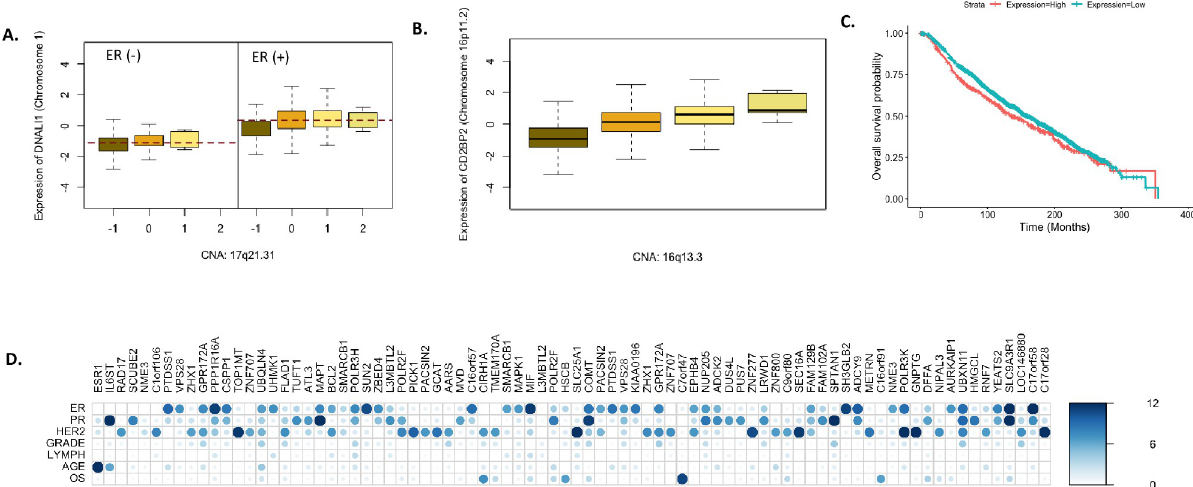
Fig 3. Association analysis with breast cancer related outcomes. (A) DNALI1 gene on chromosome 1 associated with ER status and trans-regulated by a CNA of transcription factor CHD1 on chromosome 5. (B) Trans regulation of CD2BP2 gene on chromosome 16p11.2 by a CNA in ZNF263 gene located in chromosome 16q13.3 which are approximately 27Mb apart. (C) Association of CD2BP2 expression level with overall survival probability. Expression levels have been dichotomized as high and low using 75-th percentile as cut-off. (D) p-values of 72 genes identified to be strongly associated (p-value < 2.5 10 − 06 ) with multiple outcomes, across the 7 outcomes. P-values < 1 10 − 12 are collapsed to 1 10 − 12 for the ease of